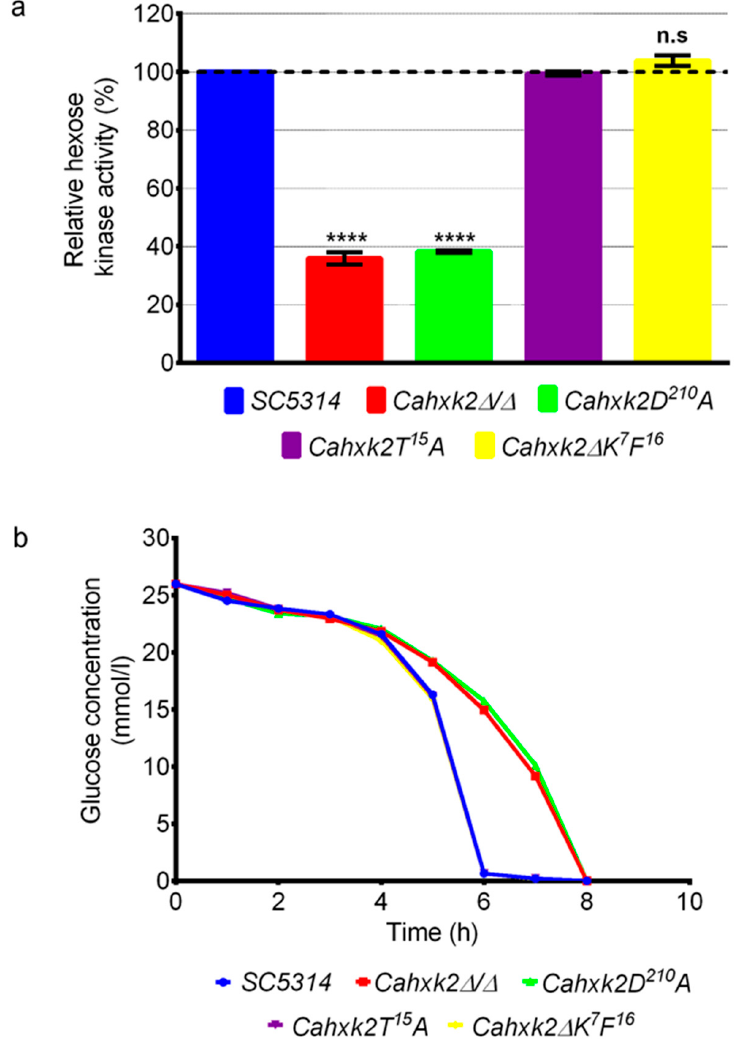
Figure 2. Relative hexose kinase activity and glucose consumption by C. albicans wild-type strain (SC5314), Cahxk2 deletion ( Cahxk2 Δ / Δ ) and punctual mutants ( Cahxk2 ∆ K 6 F 16 , Cahxk2T 15 A and Cahxk2D 210 A ). ( a ) Hexose phosphorylation activity in wild-type and mutant C. albicans cell extracts obtained from YPG log phase cultures (2% glucose). For each strain, the amount of glucose-6- phosphate produced was measured and expressed as a percentage of the wild-type strain. Data are presented as a mean (+standard deviation) of three independent experiments performed on three different biological samples, in triplicates ( n = 9). **** p < 0.0001; one-way ANOVA using Tukey’s method. n.s. = not significant. ( b ) Glucose consumption over a period of eight hours in 0.5% glucose medium. YPG (0.5% glucose) was inoculated to OD = 0.2 with stationary phase cells grown in 2% lactate. Glucose content, before inoculation, was measured to 25.96 mm/L. Data represent the mean of three